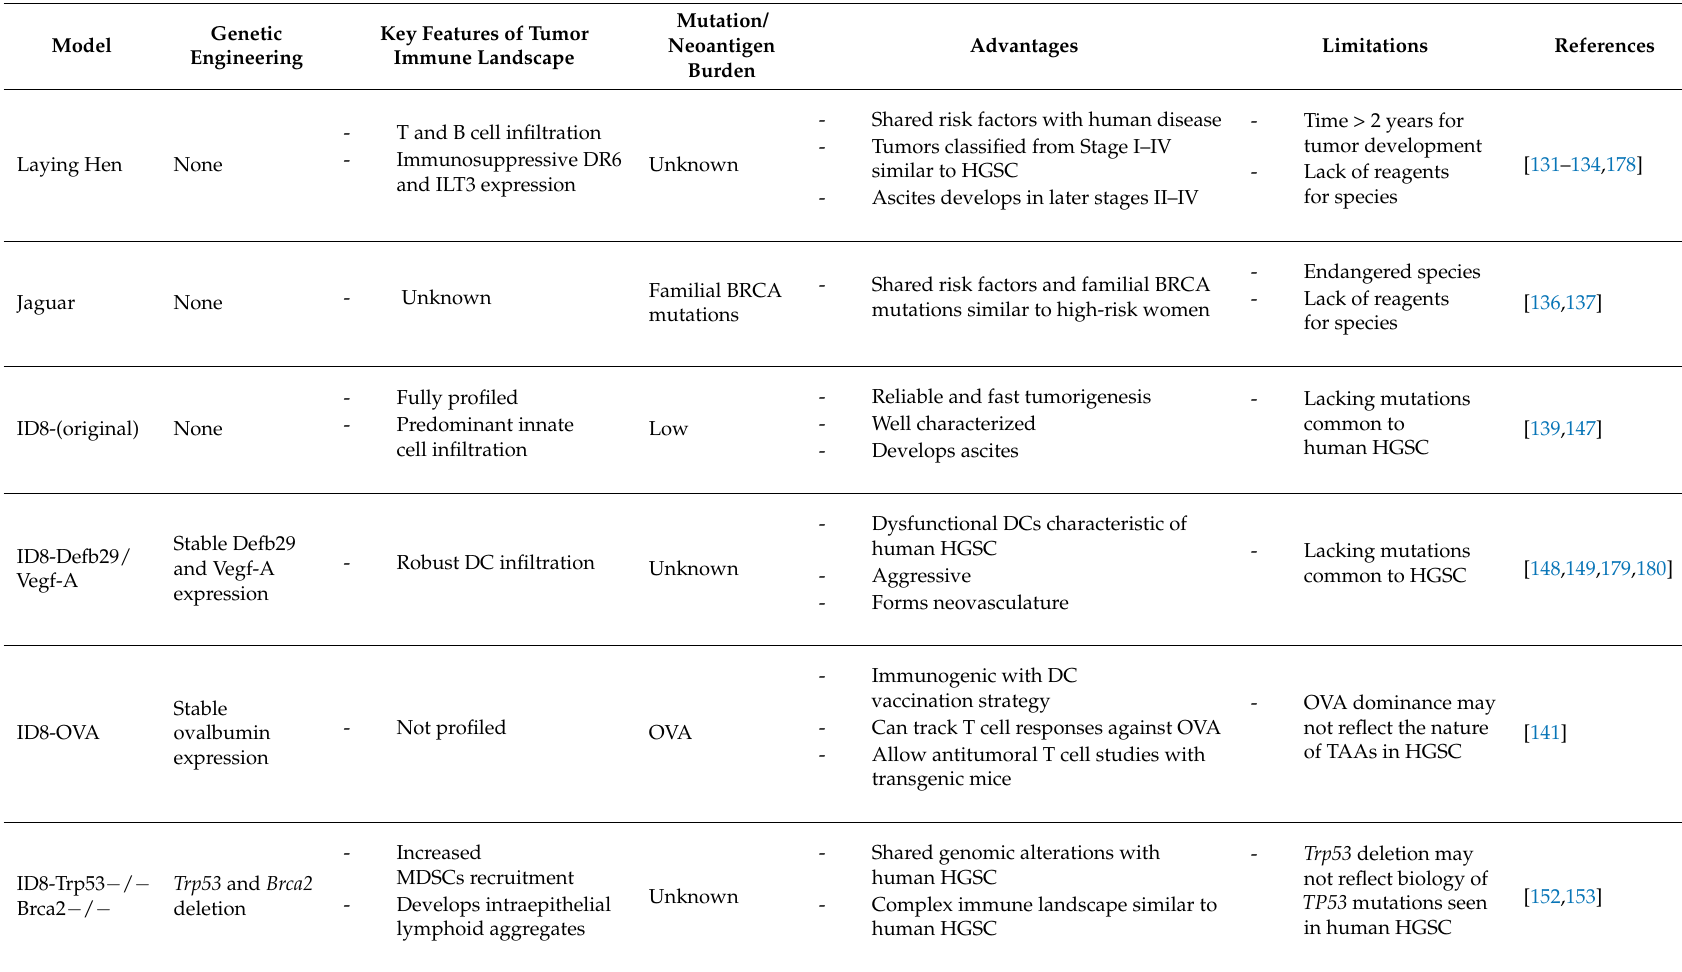
Table 2. The utility of spontaneous and syngeneic models of ovarian